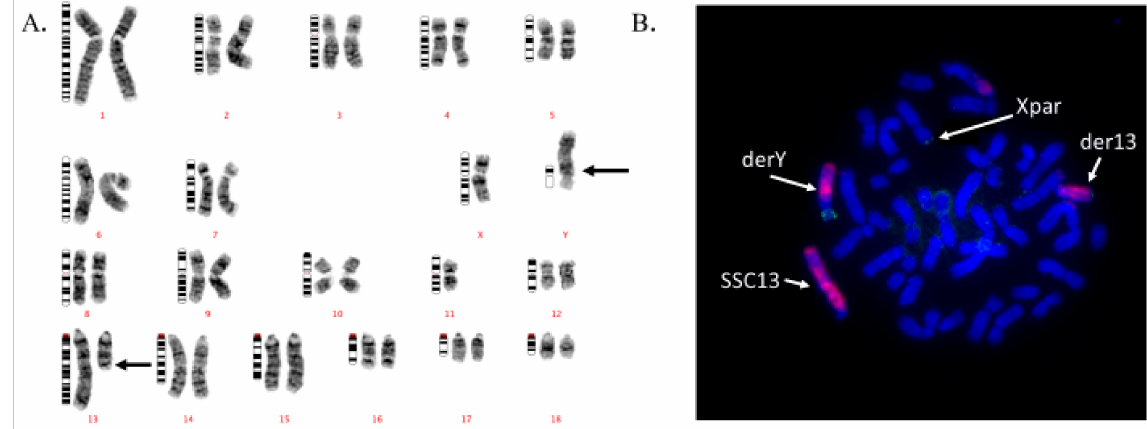
Figure 2. ( A ). GTG-banded karyotype of the t(Y:13) translocation carrier boar. ( B ). FISH chromosome painting of a metaphase plate from the t(Y:13) carrier, green signal pains the Y-chromosome segments, and redish signal pains the SSC13 chromosome segments. The presumptive psuedoautosomal region (green dots) on the X-chromosome is